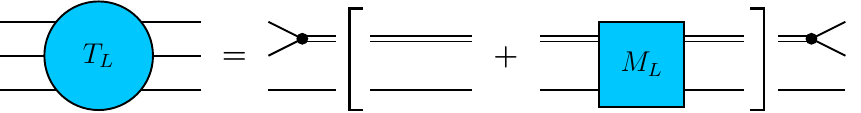
Figure 2 . Expressing the three-particle scattering amplitude through the particle-dimer scattering amplitude, see eq. (2.13). The single and double lines are the particle and the dimer propagators, respectively, and the filled circle denotes the two-particle-dimer